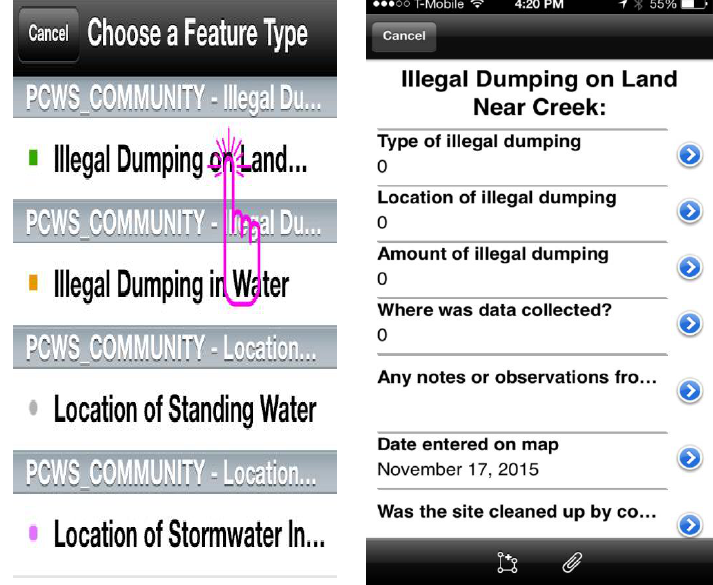
Figure 1. Examples of entry fields for data entry in the Proctor Creek Watershed Citizen Science App. Table 1. Hazard-specific data choices from drop-down menus collected in the Proctor Creek Watershed Citizen Science App.